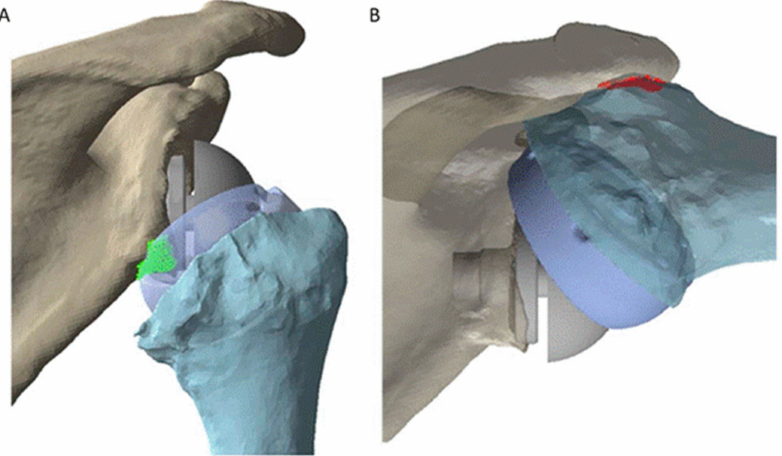
Figure 2. A rigid body model used to quantify postoperative shoulder ROM following RSTA [59]. A contact detection algorithm was employed to evaluate intra-articular ( A ) and extra-articular ( B ) impingement of the humeral component on the